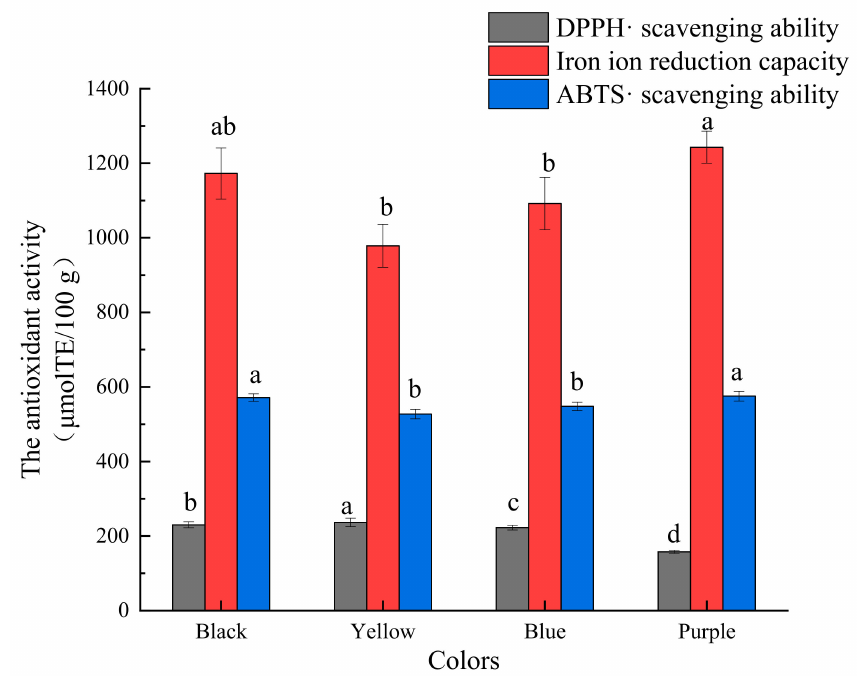
Figure 5. In vitro antioxidant capacity of anthocyanin fractions from barley of different colors. Lower- case letters in the table indicate significant differences among different colors of barley ( p <